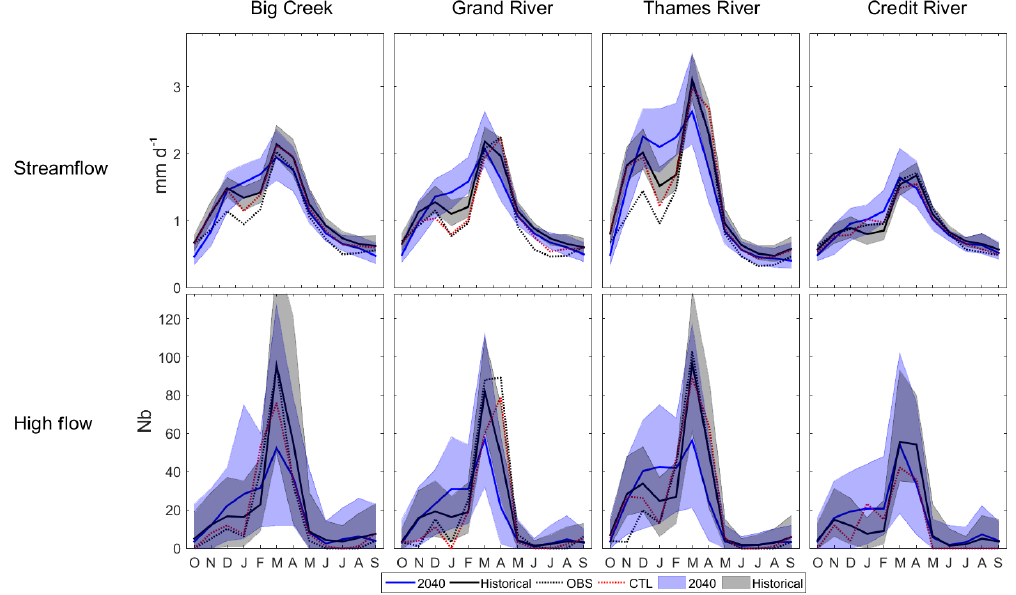
Figure 3. A 50-member range and average of streamflow and number high flows (Nb) for the historical and the 2040s periods.